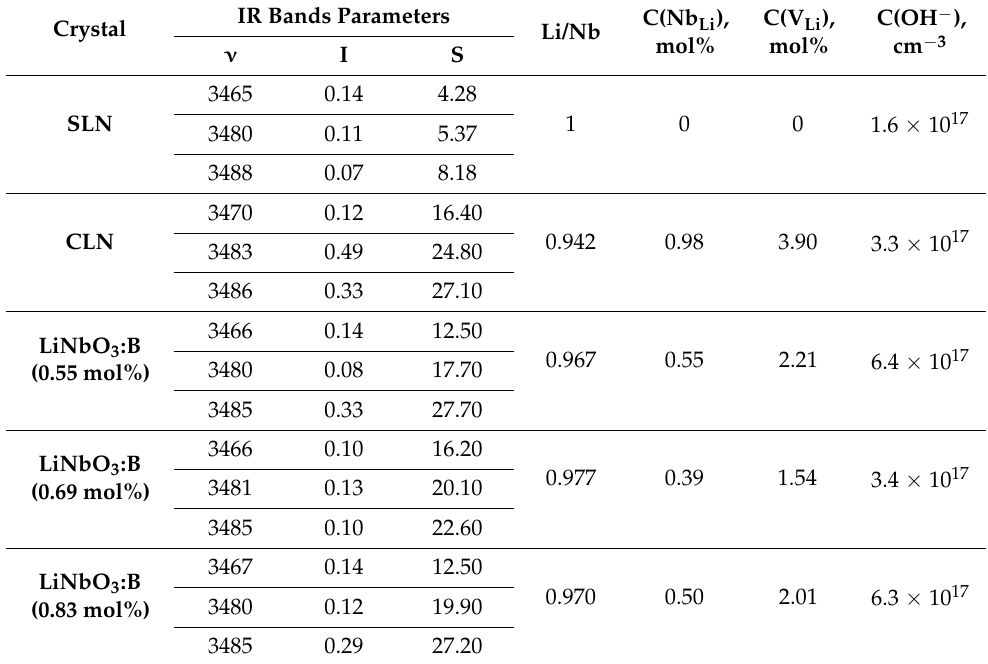
Table 2. Frequencies ( ν , cm − 1 ), widths (S, cm − 1 ) and intensities (I, rel. un.) of IR bands; OH-groups concentration (C(OH − ), cm − 3 ); concentration of Nb Li4+ and V Li − defects in crystals SLN, CLN, and LiNbO 3 :B (0.55–1.24 mol%). Table is reproduced with the permission of Pleiades Publishing from papers N. V. Sidorov et al., Techn. Phys. 2020 V. 65 P. 627–634, DOI: https://doi.org/10.1134/S10637 84220040192 (accessed on 26 March 2021). and R.A. Titov et al., Techn. Phys ., 2021 V. 66 № 1 P.